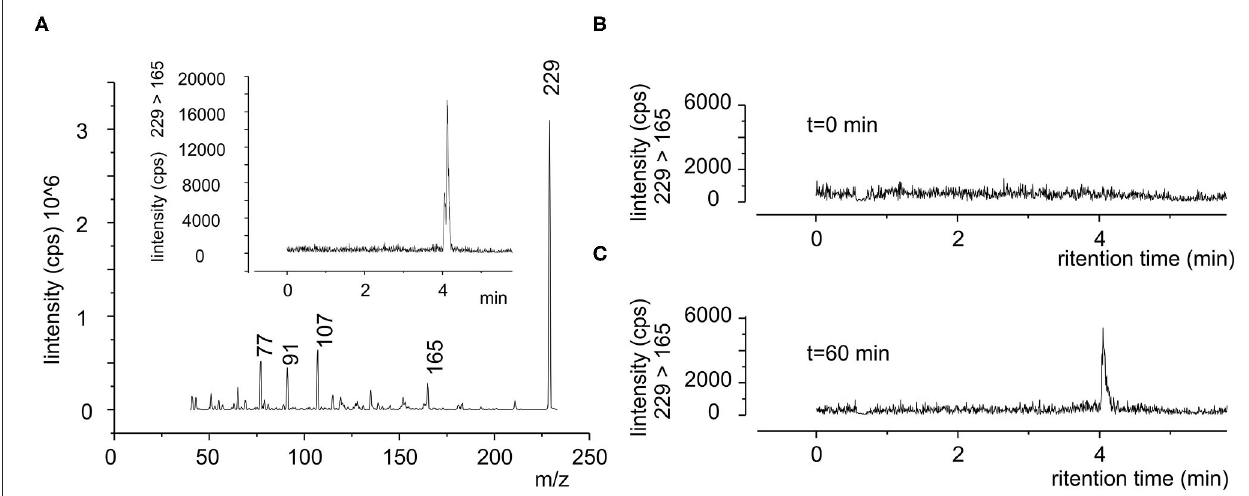
FIGURE 3 | Typical SRM chromatogram of resveratrol in human blood. (A) Product ion mass spectra of standard resveratrol (100ng/ml), where it is possible to see the principal m/z ratio of 229, 165, 107, 91, and 77 peaks. Inset chromatograms of 229-165 SRM in the same sample, shown is the retention time of resveratrol. (B,C) Blood sample obtained from same subject (subject 1) before (0min) and after 60min after the oral administration of a single dose of pure resveratrol (180mg), respectively.